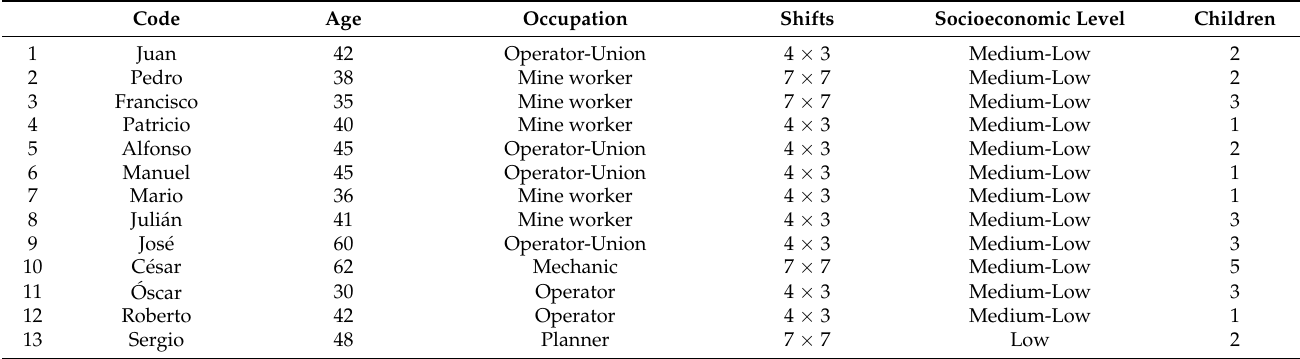
Table 2. Participants’ characteristics.